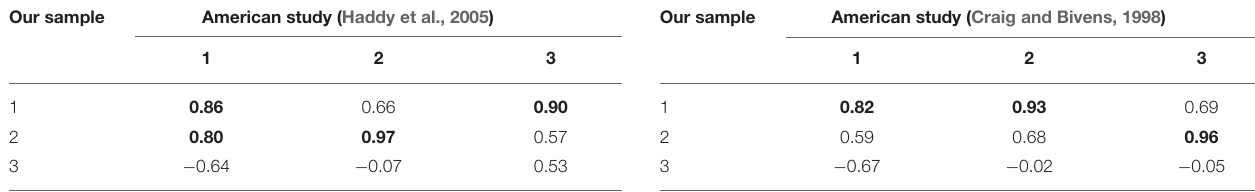
TABLE 7 | Coefficients of congruence ( 8 ) between factors of our sample and American study ( Craig and Bivens, 1998). Our